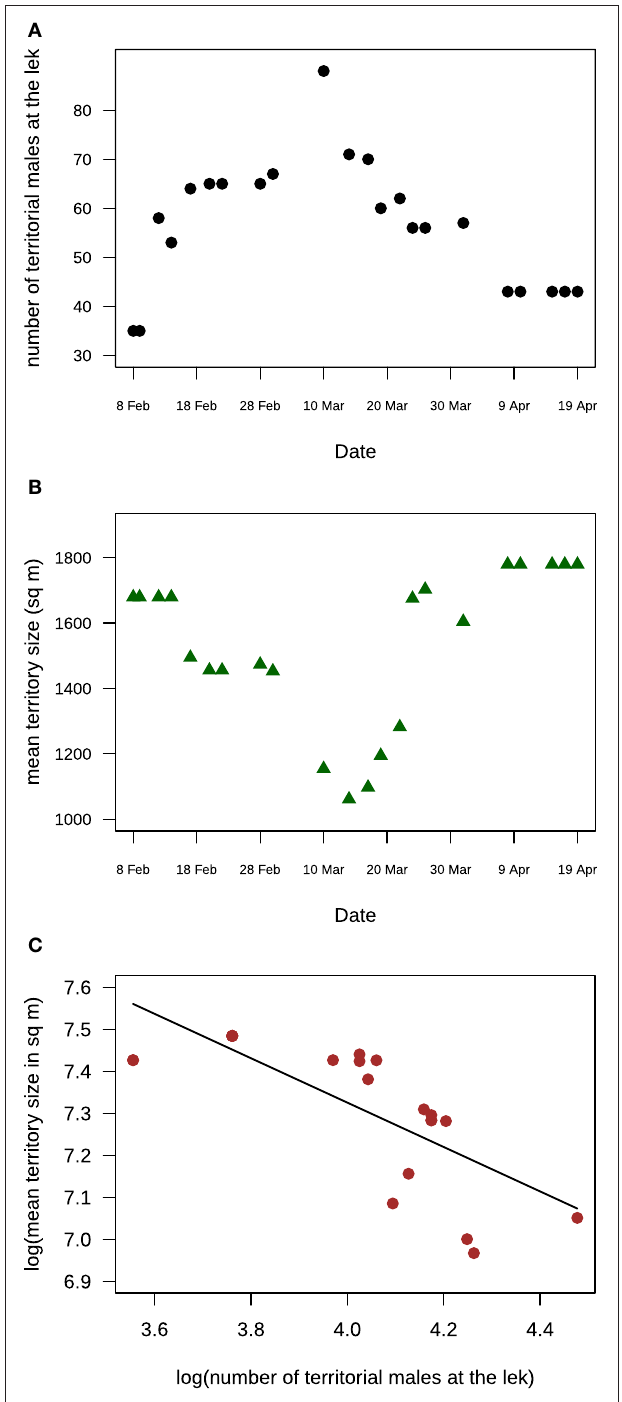
FIGURE 4 | Temporal variation in territory size and male numbers at the main lek in Velvadar indicated that mean territory size was negatively correlated with the number of males holding lek-territories (A) The number of males holding territories at the main lek in Velavadar increased, peaked and then decreased during the March-April mating peak, from 8 Feb to 19 April 2001. (B) Mean territory size at the main lek in Velvadar decreased to a minimum and then ( Figure 6 ). The mean number of females per scan per unit increased during the same mating season. (C) Mean territory size was area decreased rapidly with distance from the center of the (Continued)